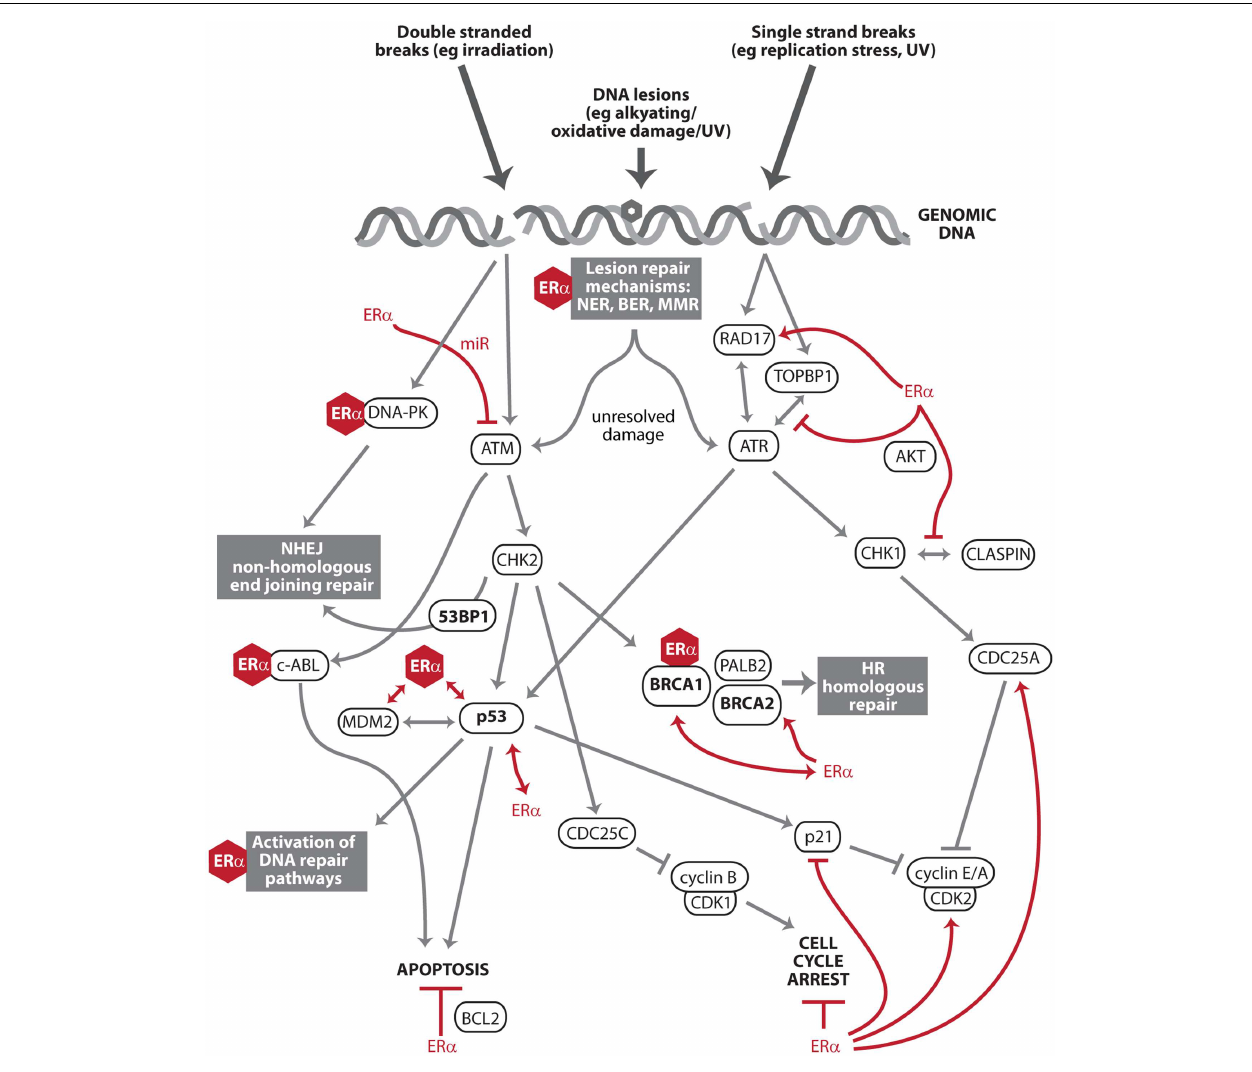
repair pathways (e.g., DNA-PK, BRCA1, p53, and MDM2).These protein:protein interactions are denoted by ER α represented as a hexagon. This includes c-Abl, a multi-functional regulator of the DDR and its downstream pathways (14). ER α also transcriptionally regulates or is regulated by other members of these pathways (e.g., ATM, ATR, CHK1, BRCA2, and DNA damage checkpoint protein Rad17), denoted by red lines. ER α signaling antagonizes two major endpoints of DDR action: apoptosis and cell cycle arrest (red